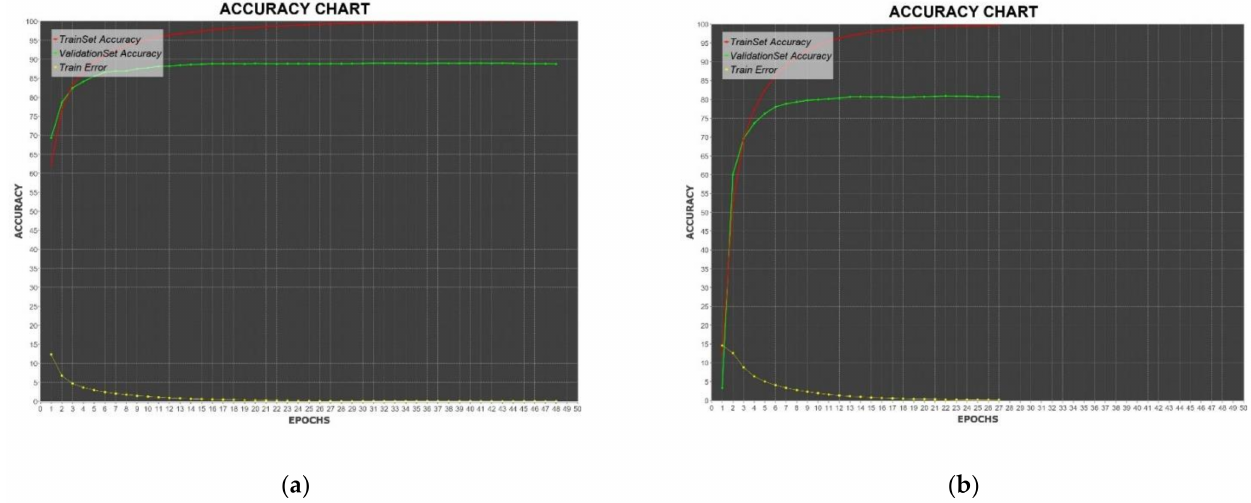
Figure 12. Training comparison with normal and thinned characters. ( a ) Training with normal characters (35 × 35); ( b ) training with thinned characters (35 × 35).